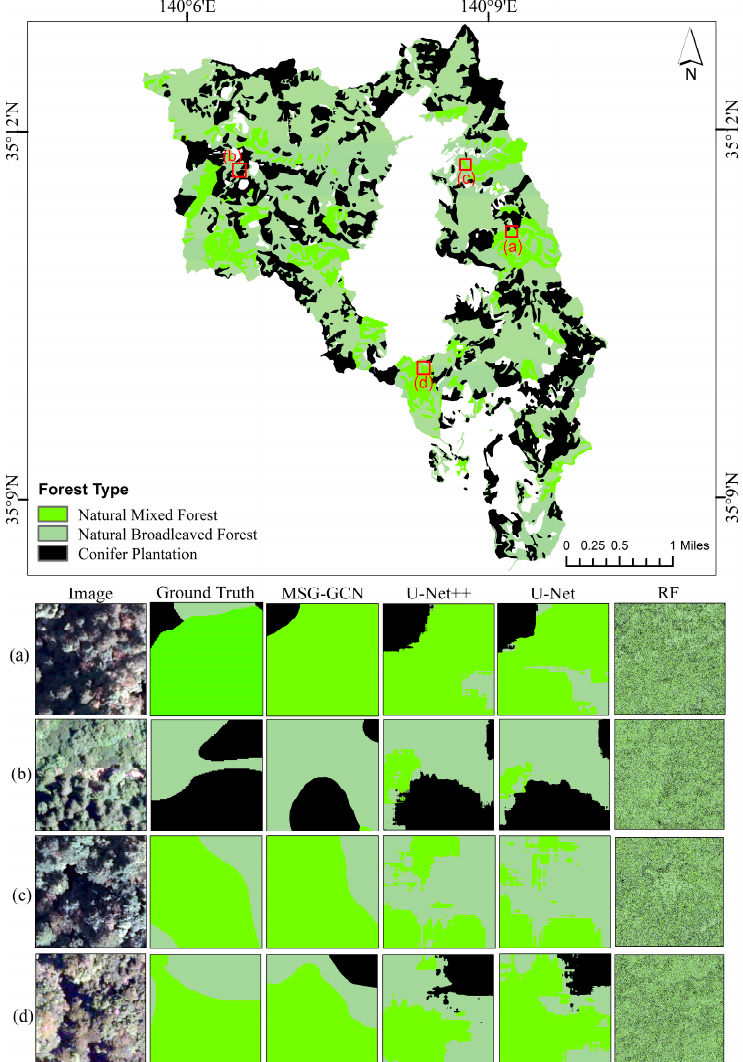
Figure 6. Ground truths of the three forest types. Example of the limitations of spectral classification (i.e., RF) and the U-Net, U-Net++, and MSG-GCN spectral–spatial classification methods. (a) a patch tile contains NMX, NBL and CP forests, (b) a patch tile contains NBL and CP forests, (c) a patch tile contains NMX and NBL forests, (d) a patch tile contains NMX and NBL forests.